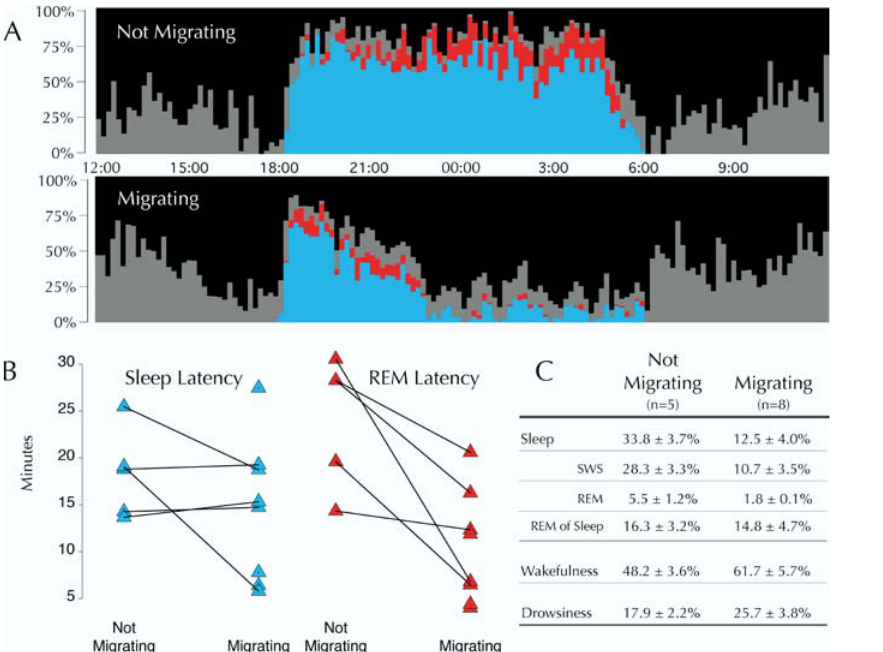
period when not migrating. (B) Sleep and REM sleep latencies. Sleep